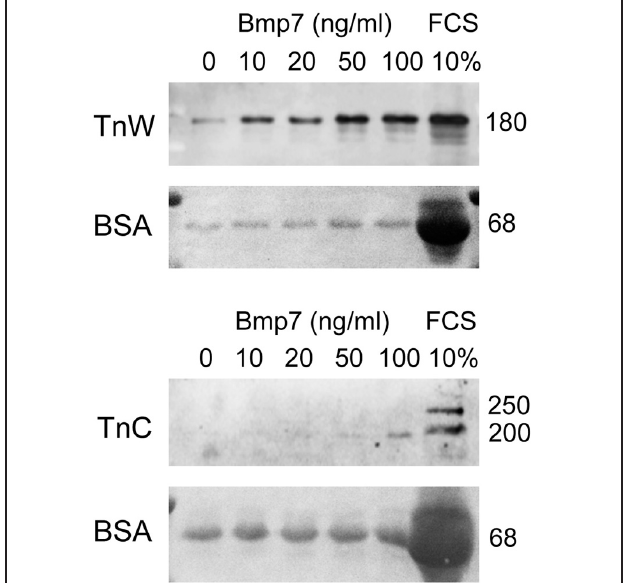
FIGURE 8 | Immunoblotting for tenascin-W (TnW) and tenascin-C (TnC) in media conditioned by mouse embryonic cranial fibroblasts, which were stimulated with the indicated concentrations of Bmp7 for 24h. The last lane of each blot shows a control culture stimulated with 10% fetal bovine serum (FCS). Below each immunoblot, Ponceau Red staining of the corresponding membrane is shown; medium-derived bovine serum albumin (BSA) was used for loading control. Numbers at right indicate protein molecular weights in